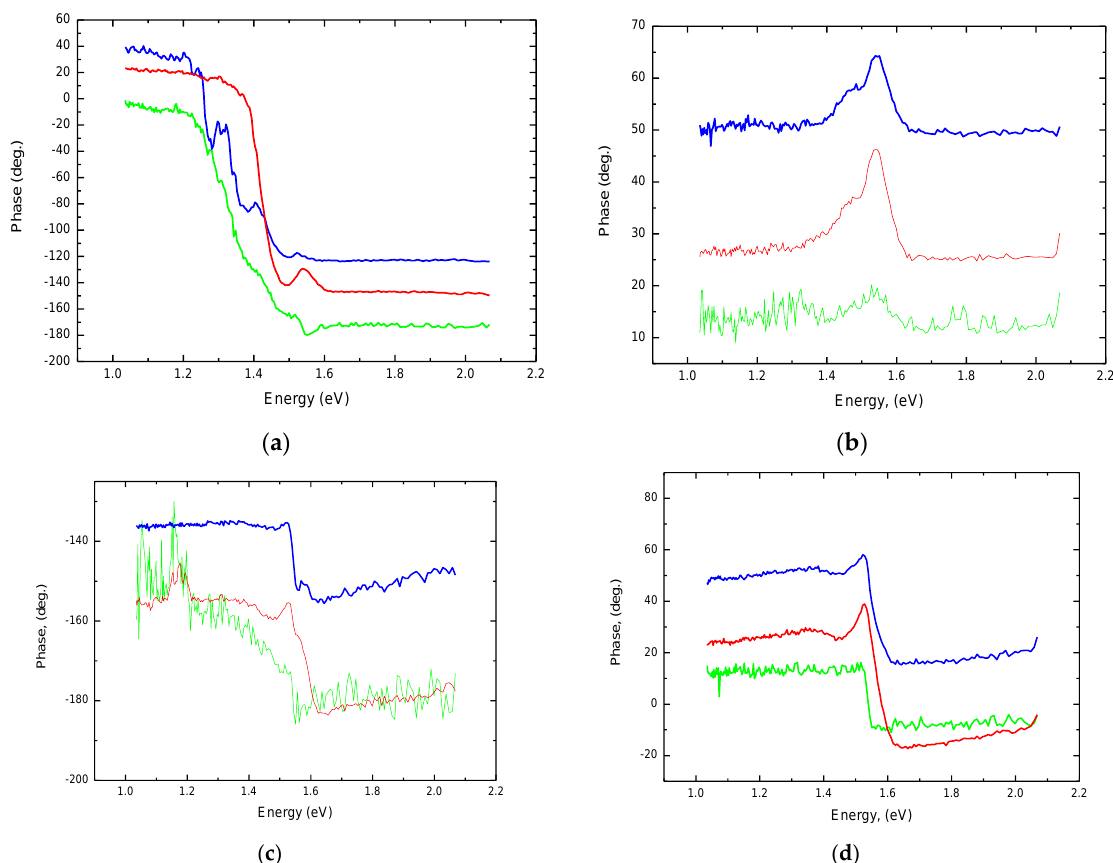
Figure 8. Phase spectra of Cd 0.95 Be 0.05 Te for front and rear detection and illumination of different surfaces at 12 Hz (blue lines), 76 Hz (green lines), and 126 Hz (red lines). ( a ) Surface 1 illuminated, rear detection. ( b ) Surface 1 illuminated, front detection. ( c ) Surface 2 illuminated, rear detection. ( d ) Surface 2 illuminated, front detection.